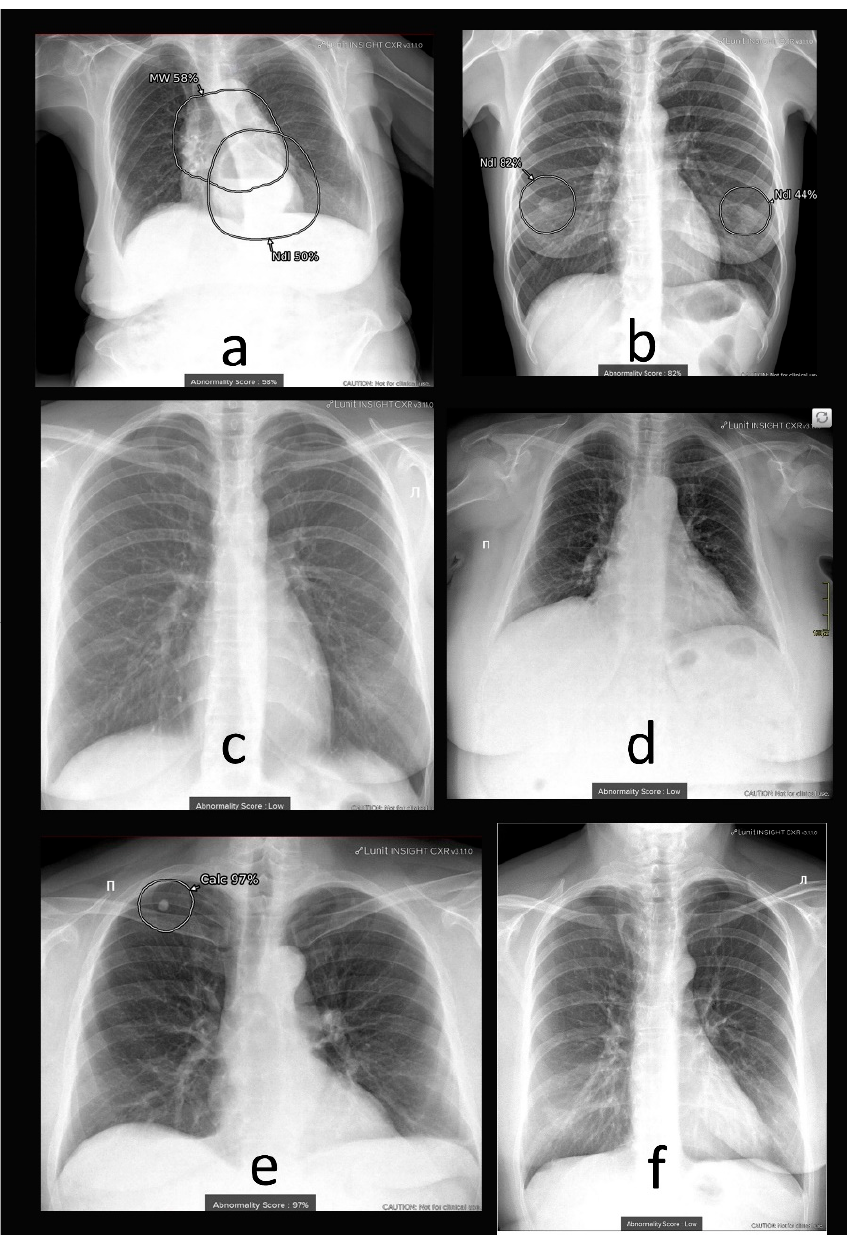
Figure 4. Examples of the ( a , b ) false-positive and ( c , d ) false-negative and ( e ) true-positive, ( f ) true- negative cases of the AI system: ( a ) patient rotation and hiatal hernia, AI erroneously detected mediastinal widening and nodule; ( b ) female patient with visible nipples, AI detected right-sided lung nodule with high probability and left-sided nodule with lower probability, but radiologist did not report any pathology; ( c ) left-sided opacity reported by a radiologist and not reported by AI; ( d ) cardiomegaly reported by radiologist and not reported by AI; ( e ) a nodule at the apex of the right lung (calcinate); ( f ) study without pathology, correctly reported by AI, but erroneously reported by radiologist as an inflammatory process in the right lung (experts did not report pathological changes, which was confirmed by subsequent computed